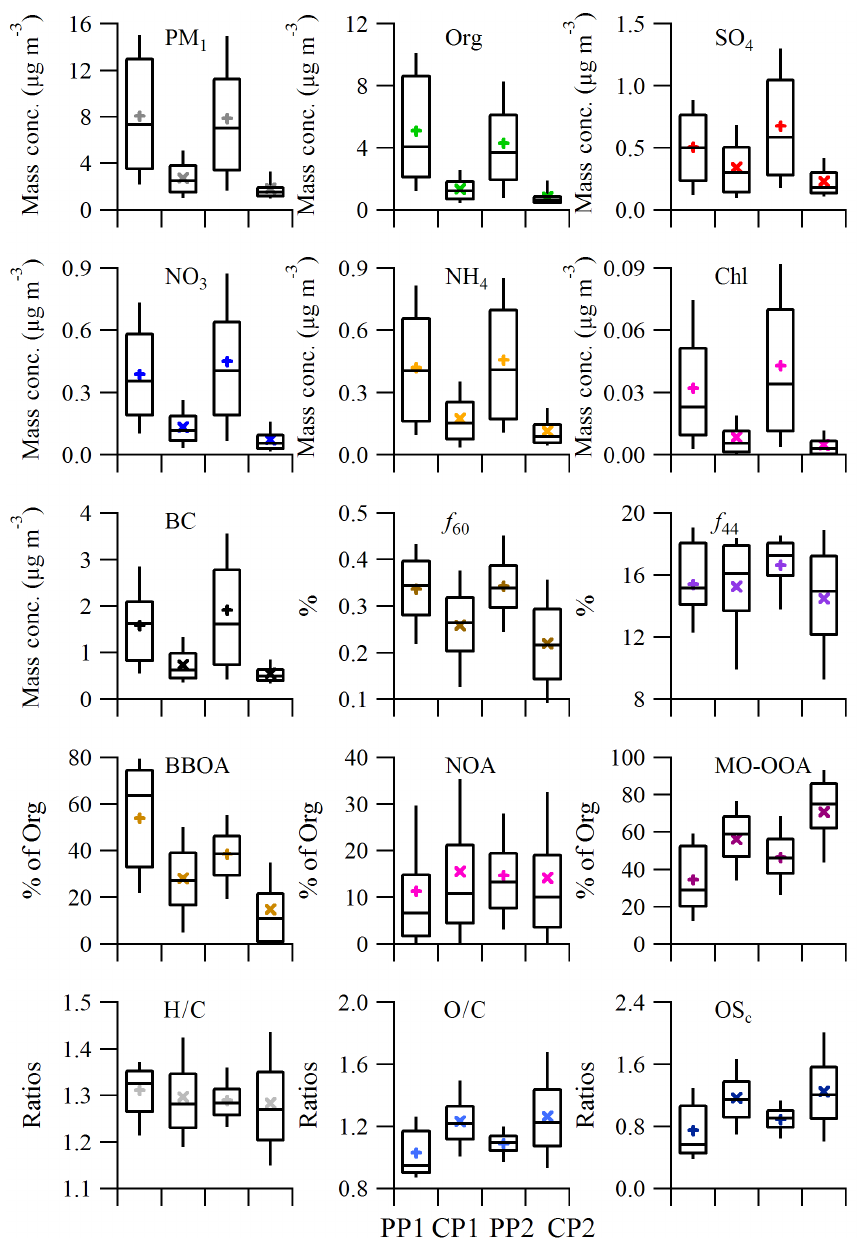
Figure 10. Box plots of mass concentrations of total PM 1 and its species, f 60 and f 44 values, mass contribution of three OA components to organics, element ratios (H / C and O / C), and carbon oxidation states (OS c ) among the four polluted and clear periods. The whiskers indicate the 90th and 10th percentiles, the upper and lower boundaries of boxes indicate the 75th and 25th percentiles, the lines in the boxes indicate the median values, and the markers indicate the mean